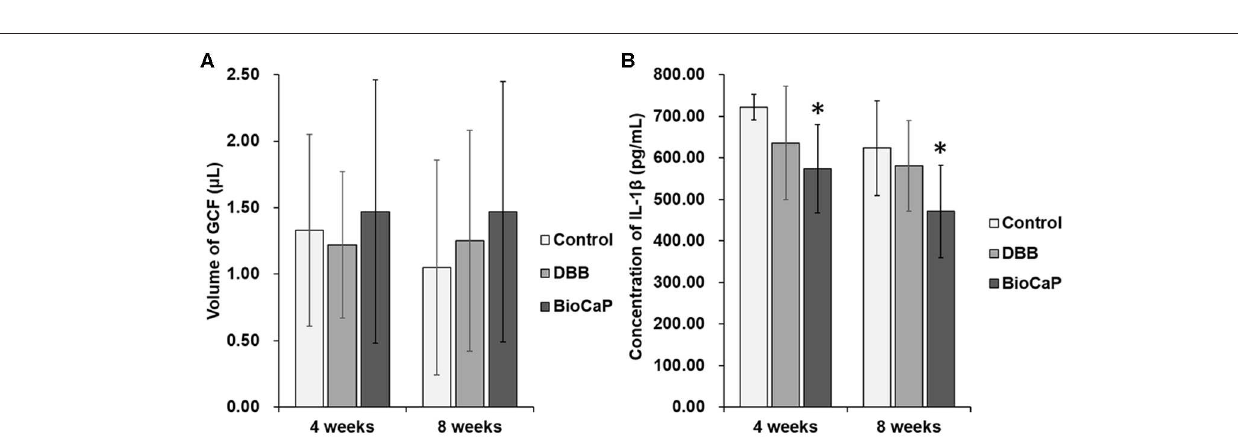
FIGURE 7 | In BioCaP group the volume of GCF was not affected but and IL-1 β concentration was reduced. (A) Volume of GCF and (B) Concentration of IL-1 β in GCF at week 4 and 8 of OTM. Data are presented as mean ± SD, from six independent experiments. Significant effect of the treatment, * p <